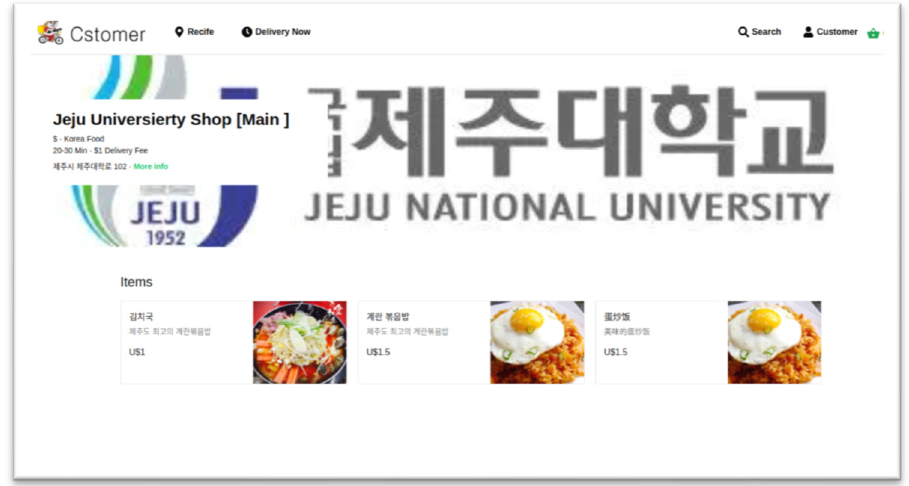
Figure 40. Client demo part in DAPP (Restaurant menu).